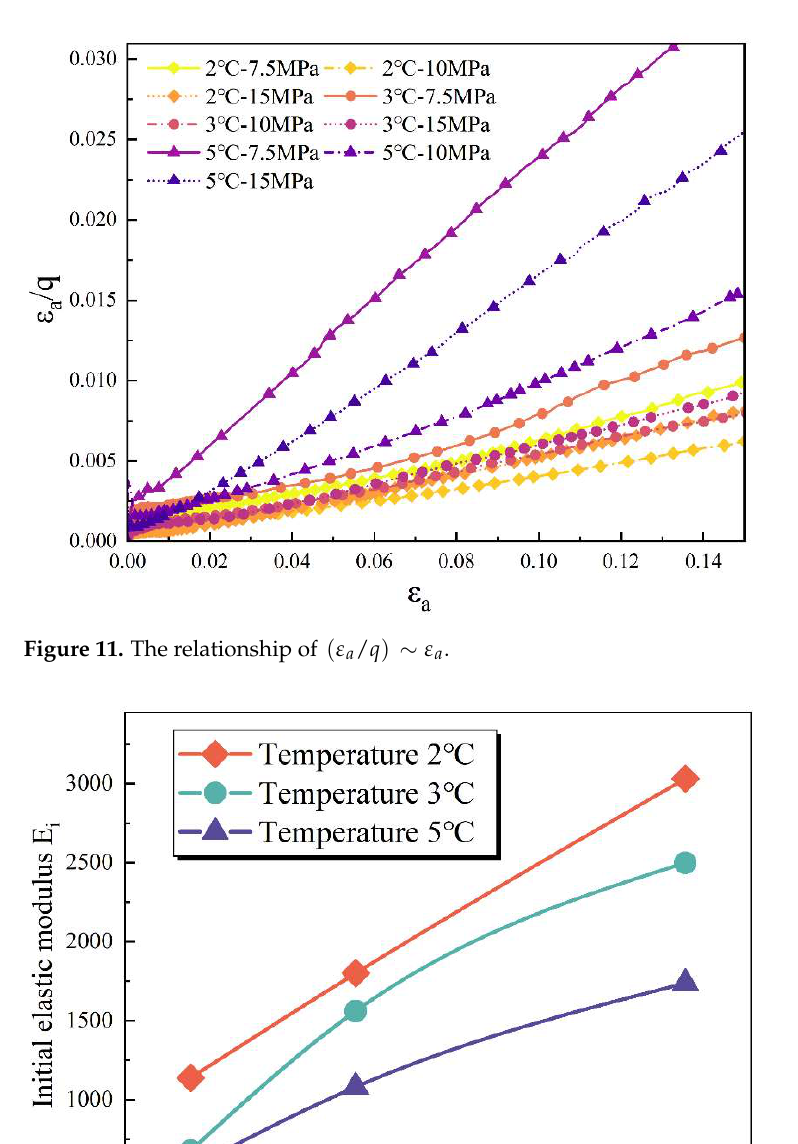
Table 2. Values of the coefficients of 𝑎 and 𝑏 .